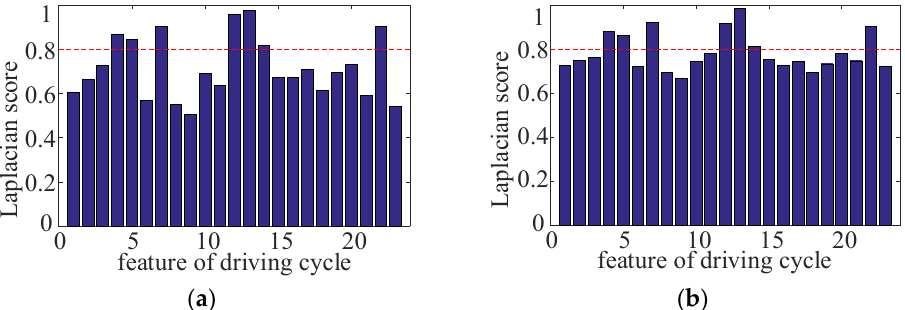
Figure 3. Laplacian scores and verification of characteristic parameters of driving cycles. ( a ) Laplace score of each feature; ( b ) verification. score of each feature; ( b )